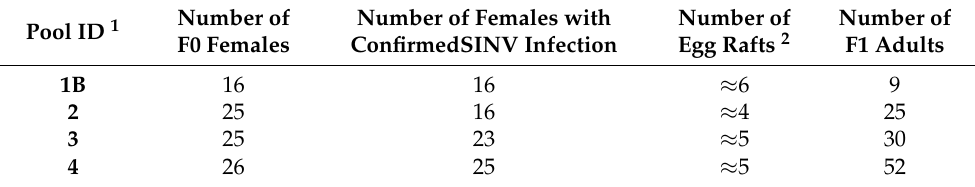
Table 2. Pooled Culex pipiens molestus females and their offspring